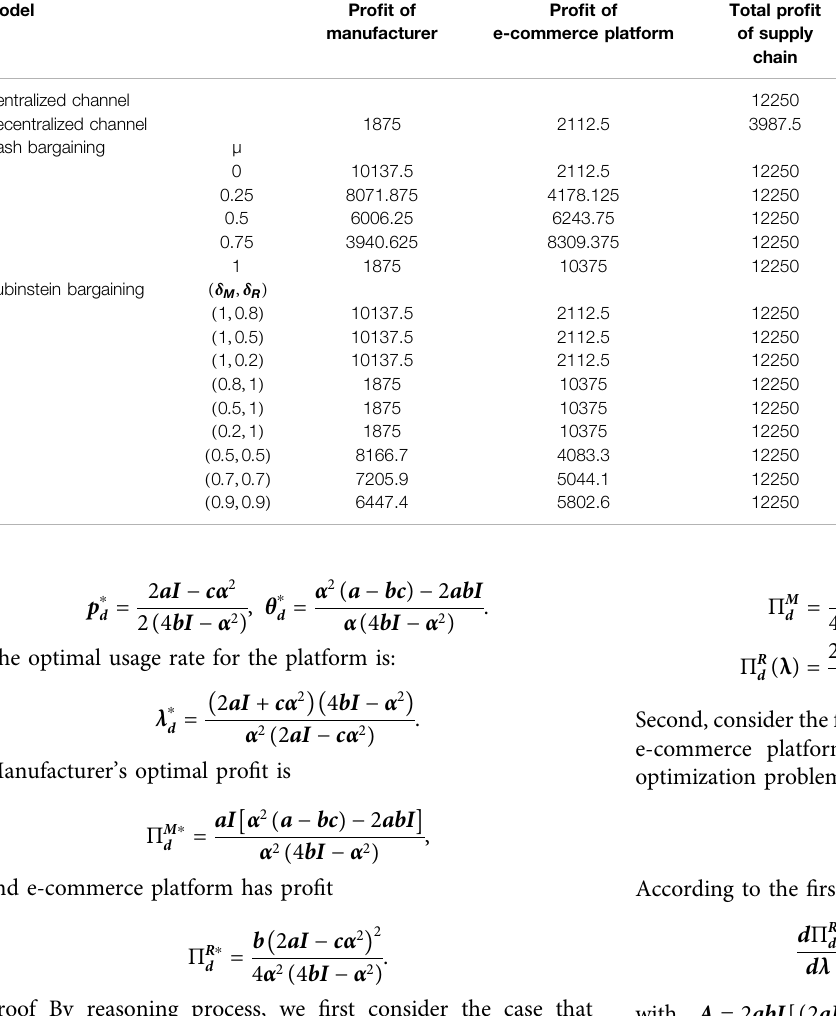
TABLE 1 | Optimal pro fi t and optimal solutions under different models.